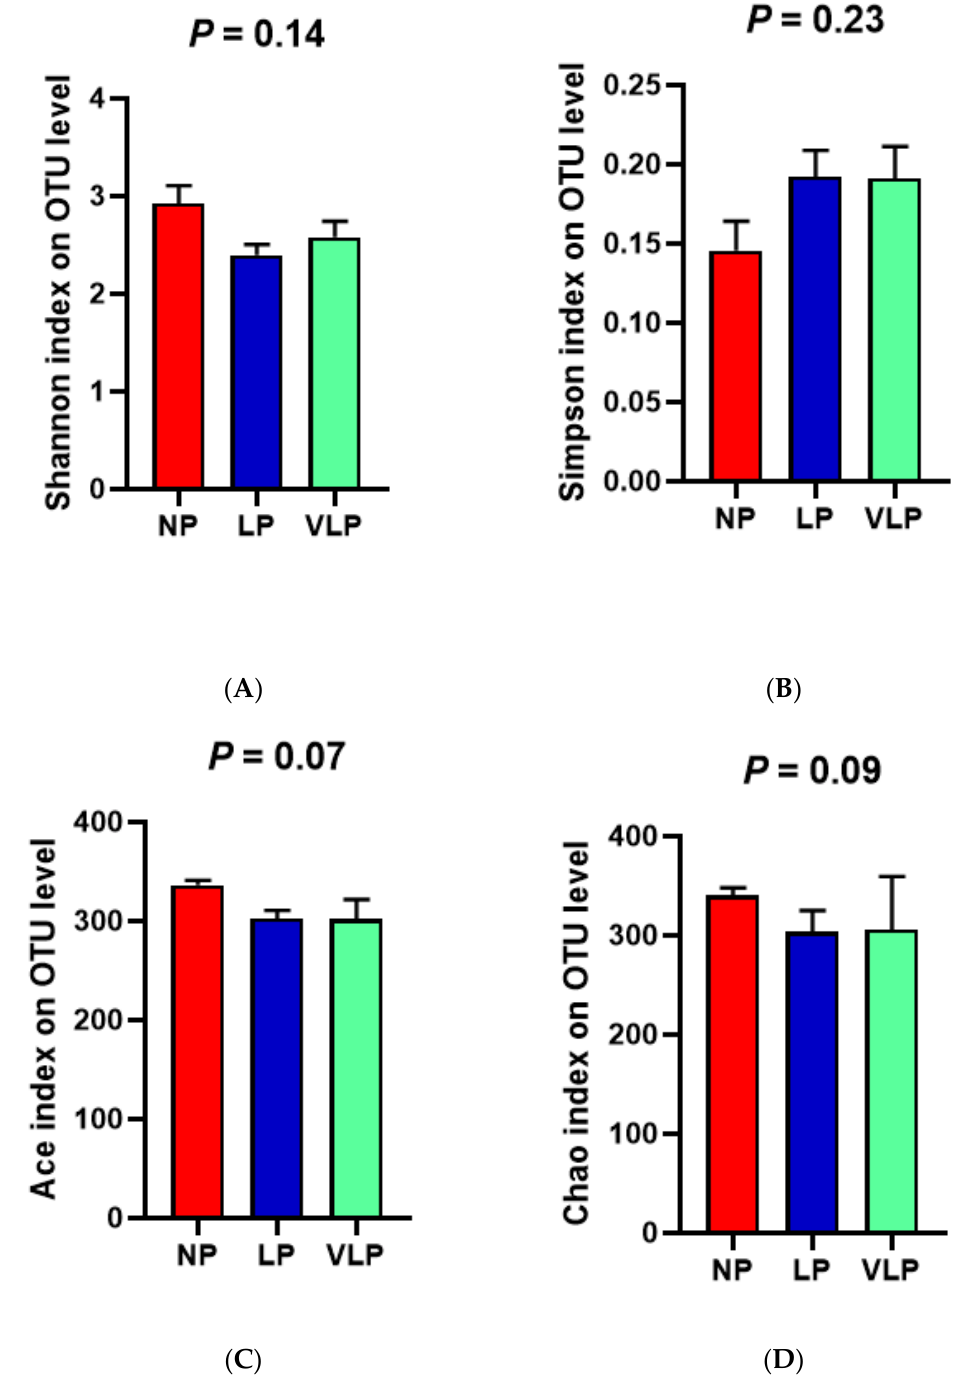
Figure 2. Effects of different protein diets on the alpha diversity of bacterial flora in the colon of finishing pigs. ( A ) Shannon index, ( B ) Simpson index, ( C ) Ace index, ( D ) Chao index. The individual pig was regarded as the experimental unit ( n = 6). NP, normal protein; LP, low protein; VLP, very low protein.